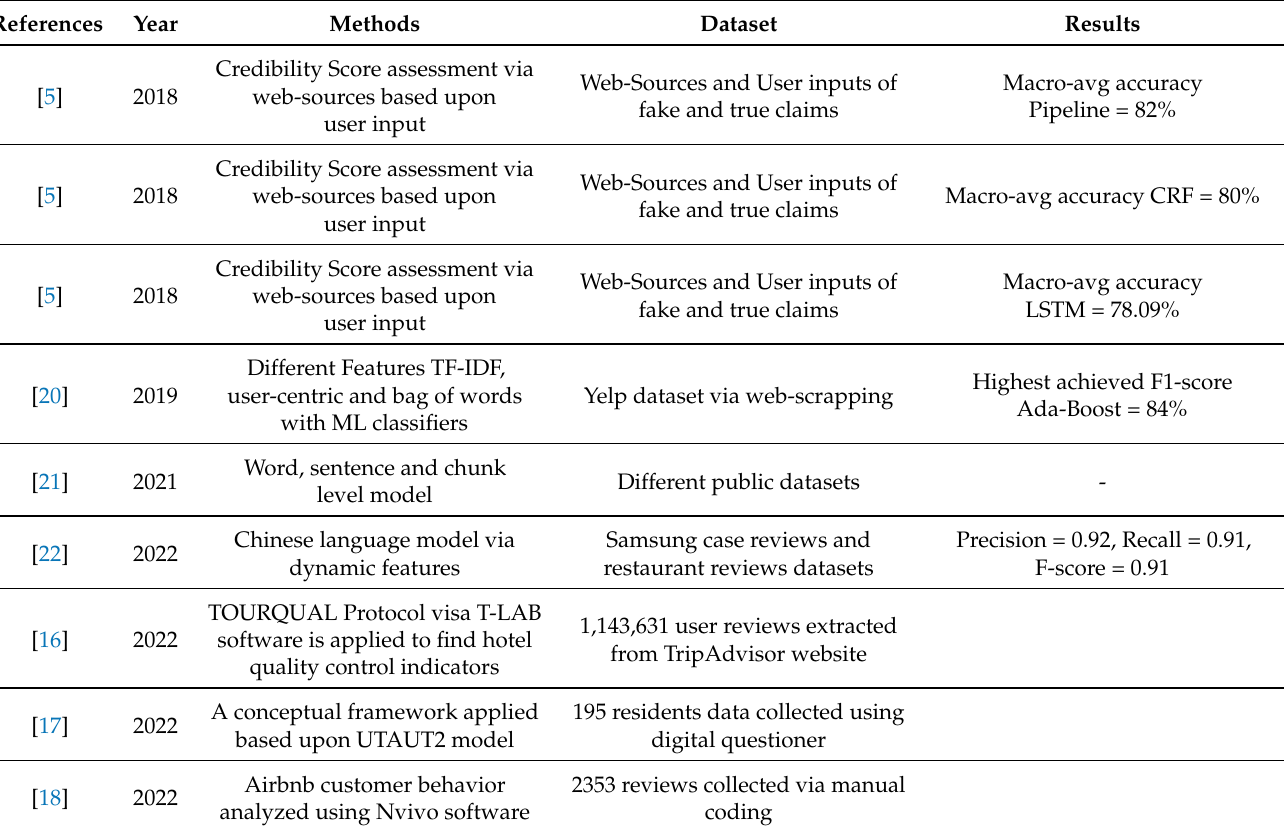
Table 1. Summary of recently applied studies on deceptive text